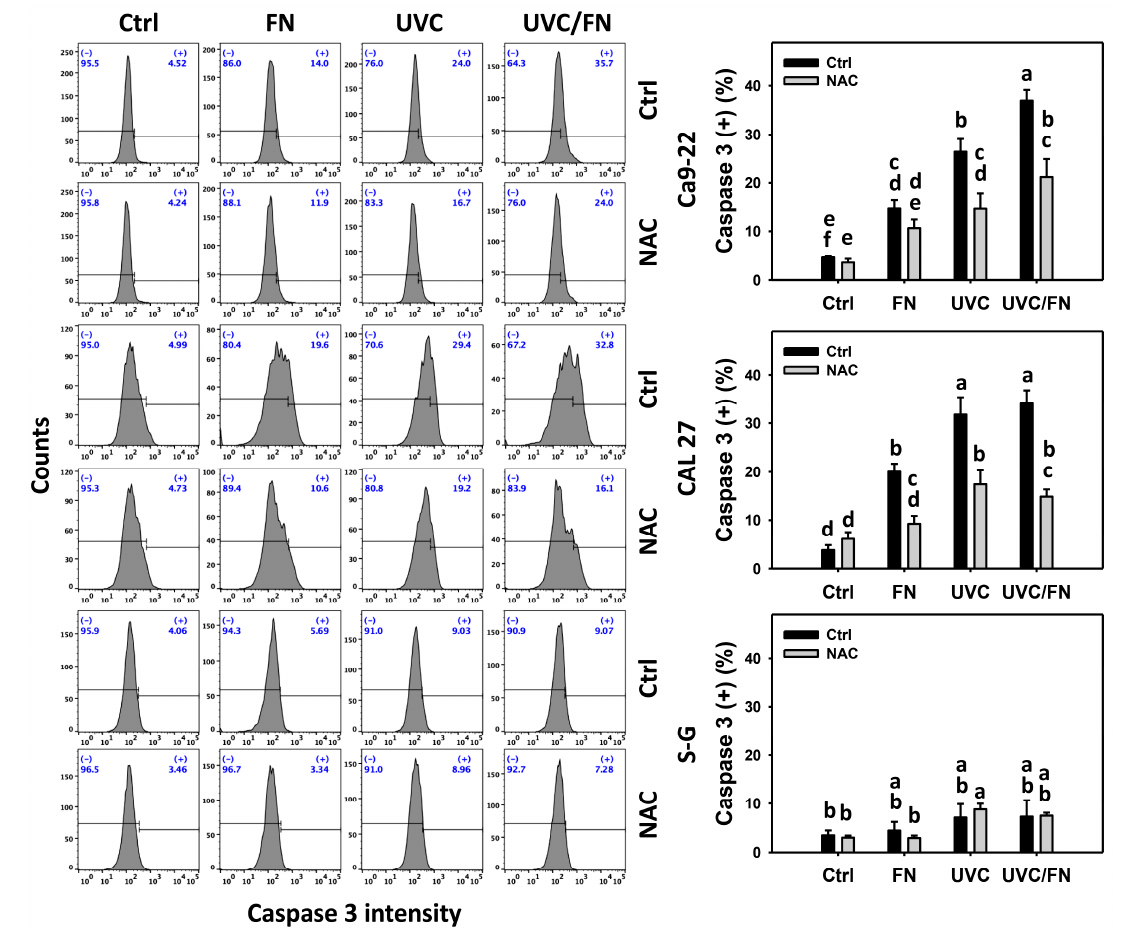
Figure 4. Caspase 3 activity determination. There are four kinds of treatments for oral cancer (Ca9-22 and CAL 27) and non-malignant oral (S–G) cells: control, FN (300 µ g/mL), UVC (10 J/m 2 for Ca9-22; 15 J/m 2 for CAL 27 and S–G), and UVC/FN (10 J/m 2 /300 µ g/mL for Ca9-22; 15 J/m 2 /300 µ g/mL for CAL 27 and S–G). NAC indicates that cells were pretreated with 10 mM NAC. Their intensity changes were evaluated by flow cytometry after 24 h treatment. Caspase 3 (+) populations are indicated with (+). Data are provided as means ± SD ( n = 3). Significant differences are indicated when lower-case letters are not overlapping ( p < 0.05).